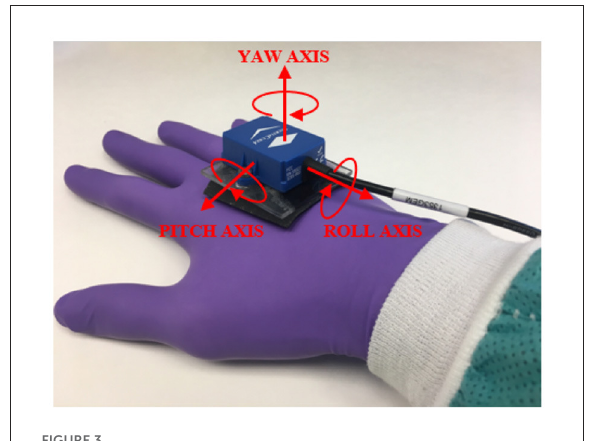
FIGURE3 Motion data collected using InertiaCube4 sensor placed on dorsum of subject’s hand.